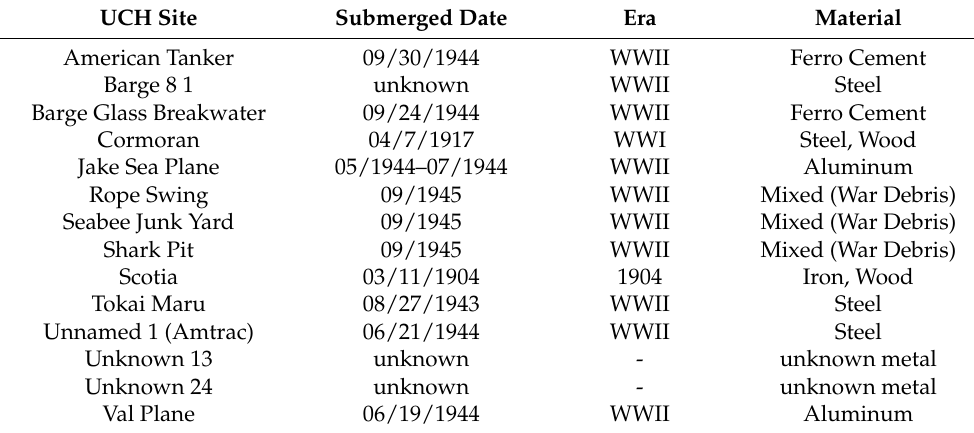
Figure 1. Study sites are in the protected Apra Harbor region ( left ) on both natural (blue) and artificial (orange) substrata. Natural reef sites from exposed reef habitats were surveyed in the Telecommunications region ( right ). Table 1. Underwater cultural heritage site descriptions. Mixed materials refers to a combination of material including metal, rubber, and wood